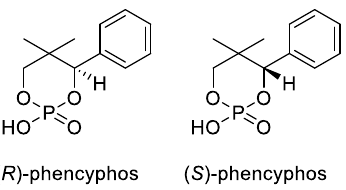
Figure 1. Enantiomers of